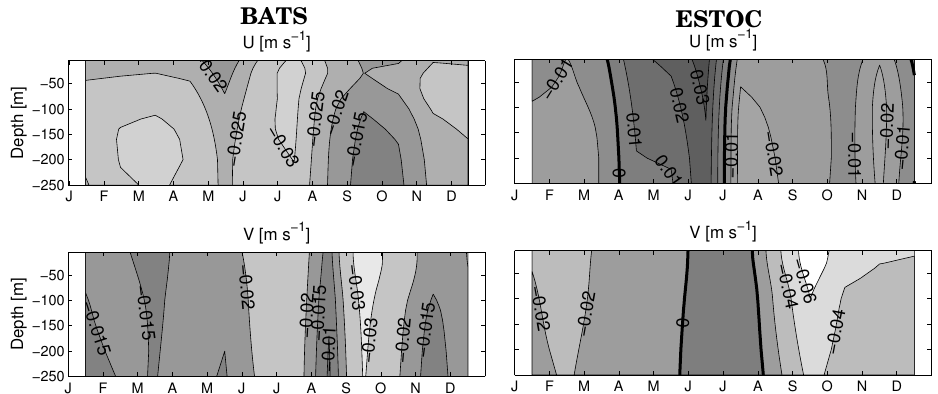
Fig. 2. Computed geostrophic horizontal velocities ( u , v ) for BATS and ESTOC. The thick black line represents the null velocity component.